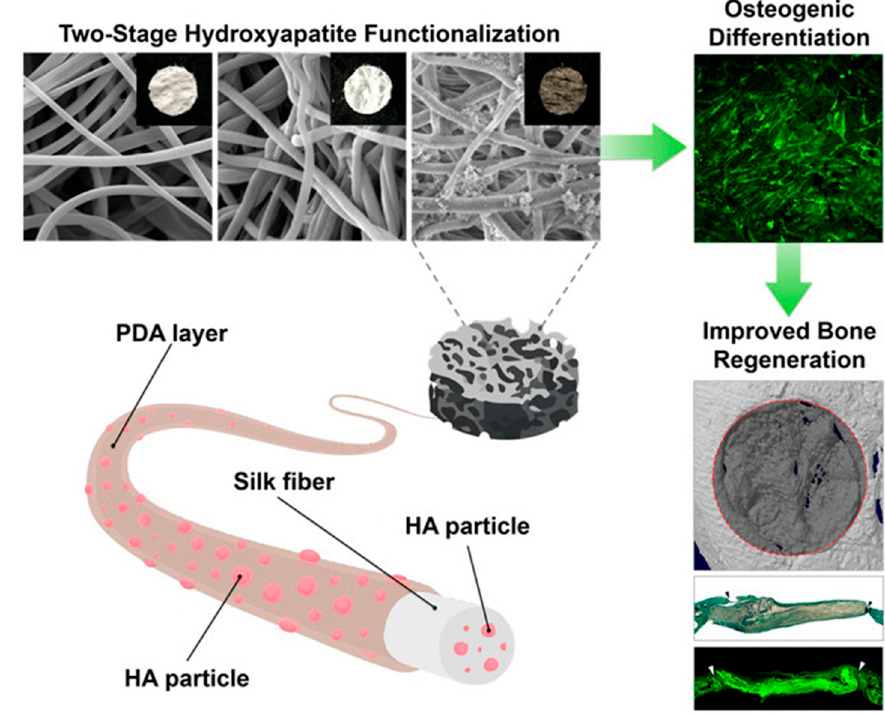
Figure 4. Schematic illustration and scanning microscopic images of the SF scaffold engineered with two-stage hydroxyapatite functionalization. Enhanced collagen deposition in critical-sized calvarial bone defects, eight weeks after human adipose-derived mesenchymal stem cell transplantation with two-stage hydroxyapatite-functionalized silk fibroin (SF) sca ff olds and improved bone regeneration. Reprinted with permission from reference [43]. Copyright (2018) American Chemical